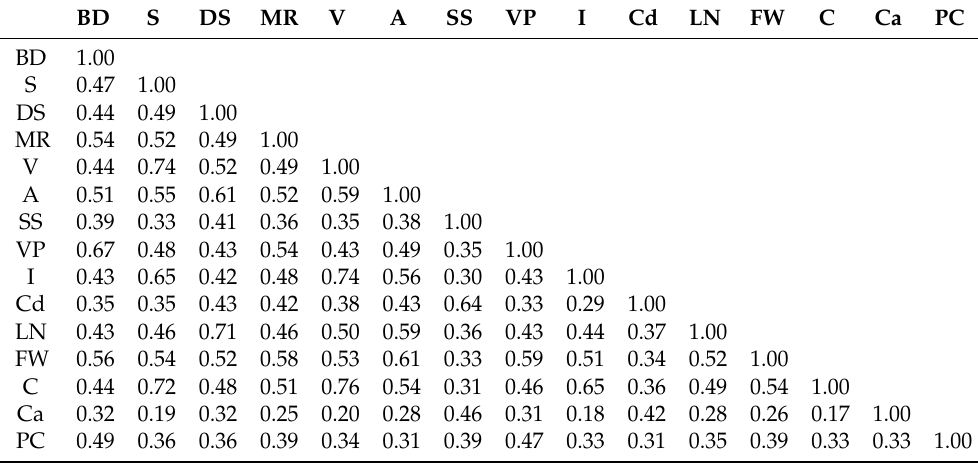
Table 2. Uncorrected correlation matrix provided by McFarland (2020): middle group.